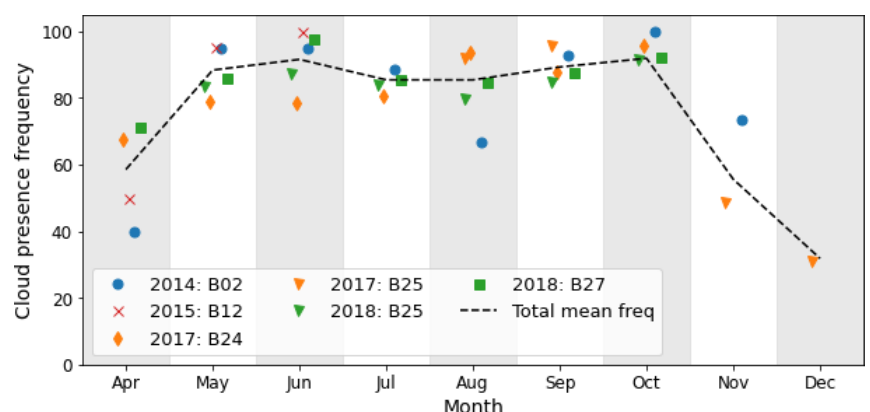
Figure 2. Monthly variation of low cloud frequency, defined as the number of profiles that contain at least one cloud layer with a base lower than 2km divided by the total number of profiles for the month for five IAOOS buoys. The dashed line represents the total monthly cloud frequency over all IAOOS profiles. It is only calculated for months with more than 30 profiles in total. Table 2. Cloud multiple layer and base characteristics for all profiles from April to December. N p is the total number of lidar profiles for each month (for all years and buoys), and N ml is the number of profiles containing multilayered clouds. The last four columns represent the percent of first layer cloud bases in each altitude range. The 120m cut-off corresponds to the minimum altitude at which the lidar overlap factor can be corrected for all buoys. Cloud bases above 5km, which correspond to high-level clouds in many reanalyses such as ERA5, are not included because the lidar range in perfectly clear daytime conditions is only 4 . 4km (Sect. 2.1). Month N p (no.) N ml (%) First cloud base N profiles